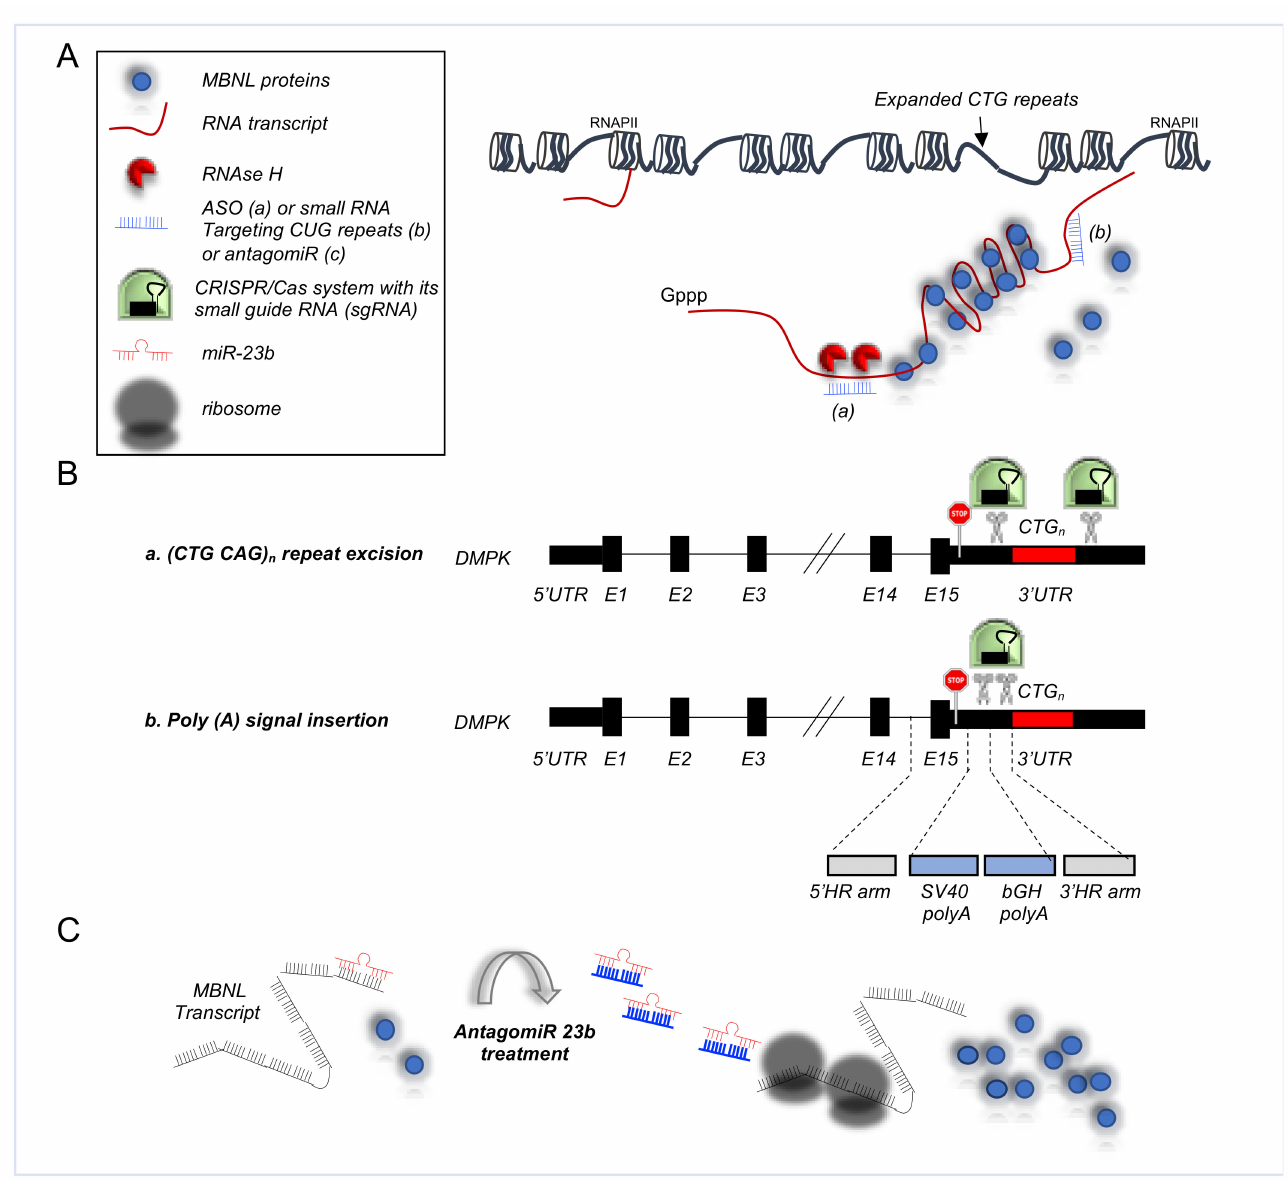
Figure 3. RNA based approaches in DM1. ( A ). ASO strategies in DM1: Once bound to the target RNA, ASOs trigger degradation via the recruitment of endogenous RNase H1 ( a ) or the RISC complex. On the other hand, ASOs complementary to CUG repeats can block MBNL recruitment ( b ) (adjusted from [116]). ( B ). 2 CRISPR/Cas9 based therapies for DM1. CRISPR/Cas system interferes with the genome via a small guide RNA (sgRNA), directing the Cas endonuclease (in green) to a DNA target that matches the sgRNA sequence located next to the proto-spacer adjacent motif, bound by Cas ( a ). The CTG expansion is excised (scissors) via dual CRISPR/Cas9-mediated cleavage, at either side of the repeats. Alternatively ( b ), the transcription of the (CTG)n repeat in DMPK can be prevented by inserting via CRISPR/Cas a premature poly (A) signal between the stop codon and the repeat, leading to premature termination of the transcript (adjusted from [96]). A limitation to this strategy is that the pathogenic repeat remains present in the genome. ( C ). AntagomiR approaches in DM1. MBNL level can be increased by blocking the downregulation of MBNL transcript by